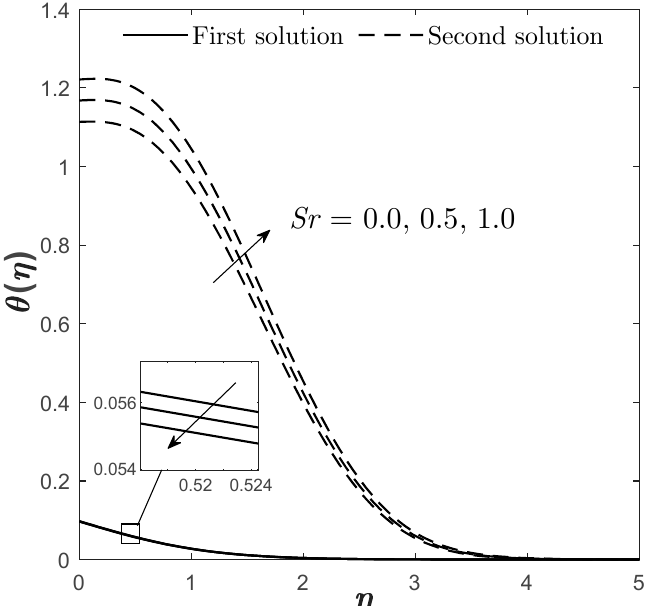
( ) θ η Figure 18. Plots of for varied Sr Figure 18. Plots of θ ( η ) for varied Sr when N = Rd = Sc = 1, Du = 0.03, λ = − 1, φ 2 = 0.01, and Figure 18. Plots of Bi = 0.1.